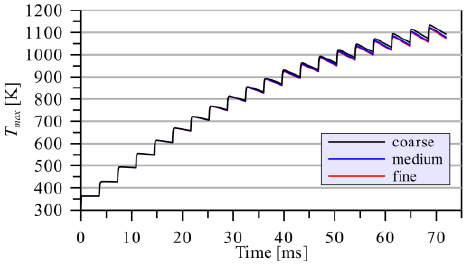
Figure 6. Maximum MLL (WC/SiC) temperature for three mesh